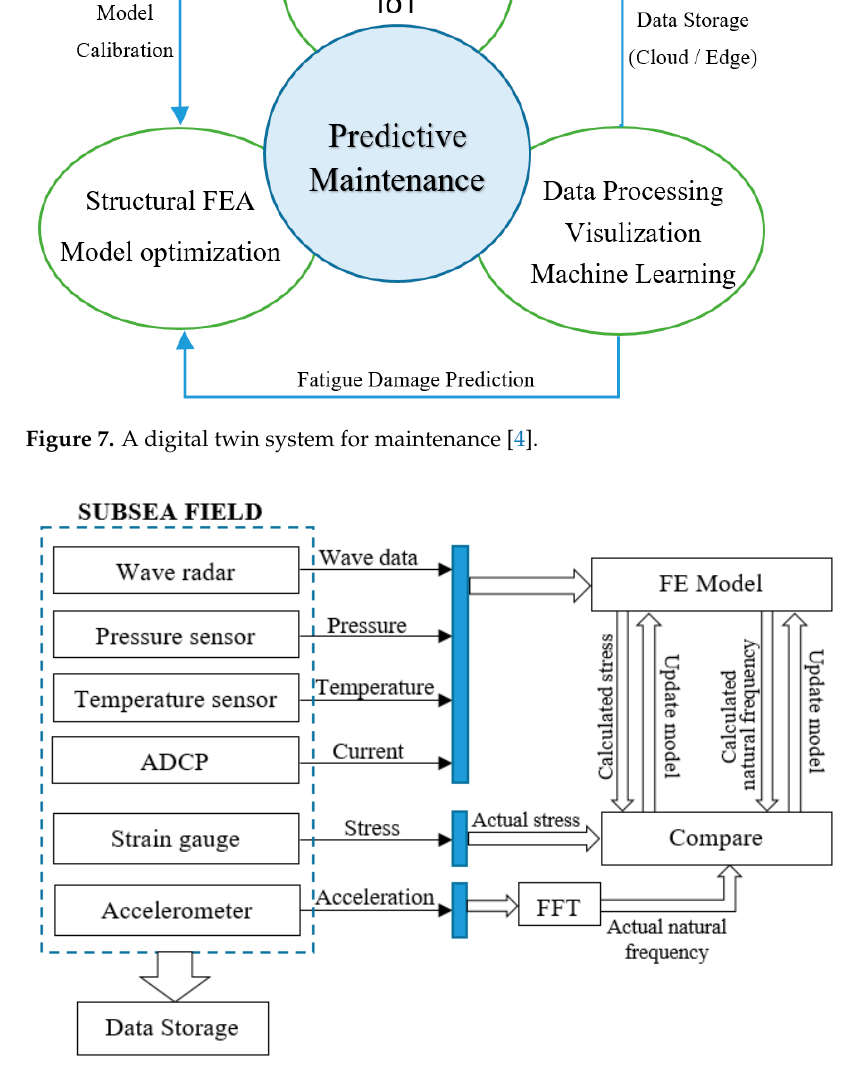
Figure 8. A field sensor system and the data-driven model [4].